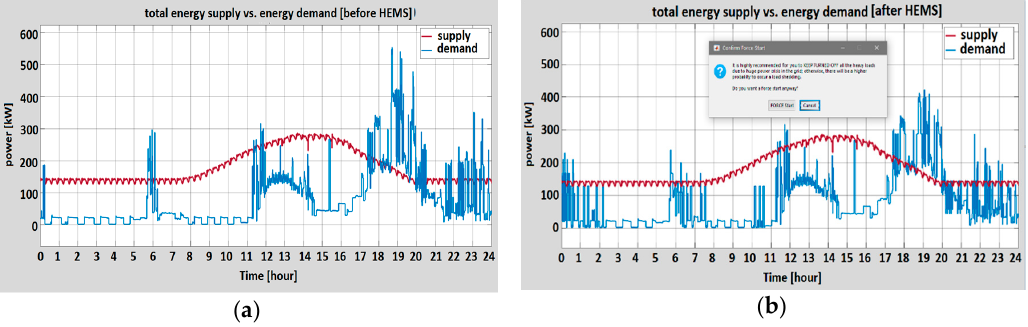
Figure 19. ( a ) Total energy supply and energy demand in Scenario A (Solar and Diesel gen.) before HEMS, and ( b ) after HEMS.